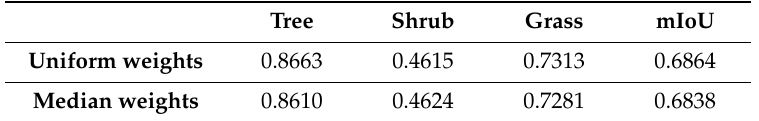
Table 20. IoU and mean IoU (mIoU) values (uniform and median weights, Oregon—3 classes).